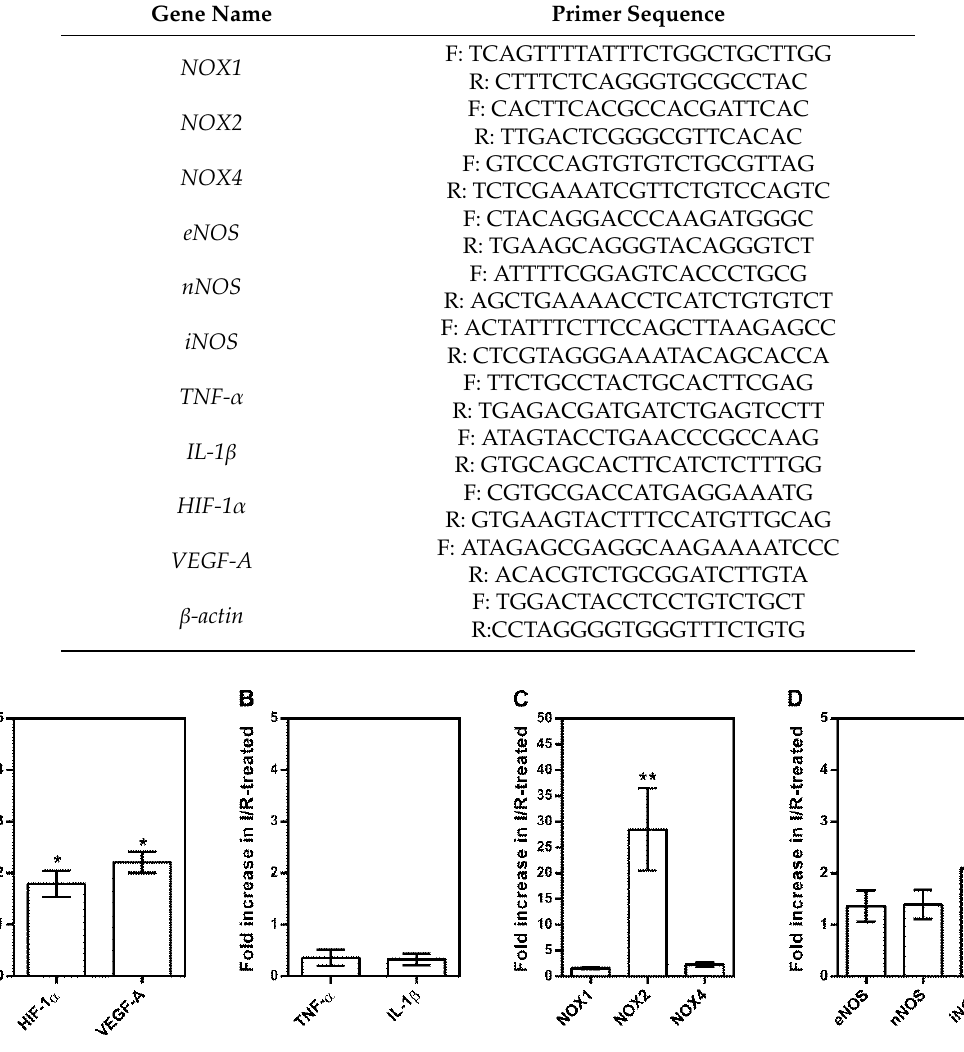
Figure 3. Messenger RNA expression for hypoxic markers ( HIF-1 α , VEGF-A ) ( A ), inflammatory cytokines ( TNF α , IL-1ß ) ( B ), prooxidant redox enzymes ( NOX1, NOX2, NOX4 ) ( C ), and individual nitric oxide synthase ( NOS ) isoforms ( eNOS, nNOS, iNOS ) ( D ). Data are presented as fold-change in mRNA expression levels in I / R-treated relative to sham-treated pigs. Data are presented as mean ± SE ( n = 6 per group; * p < 0.05, ** p <